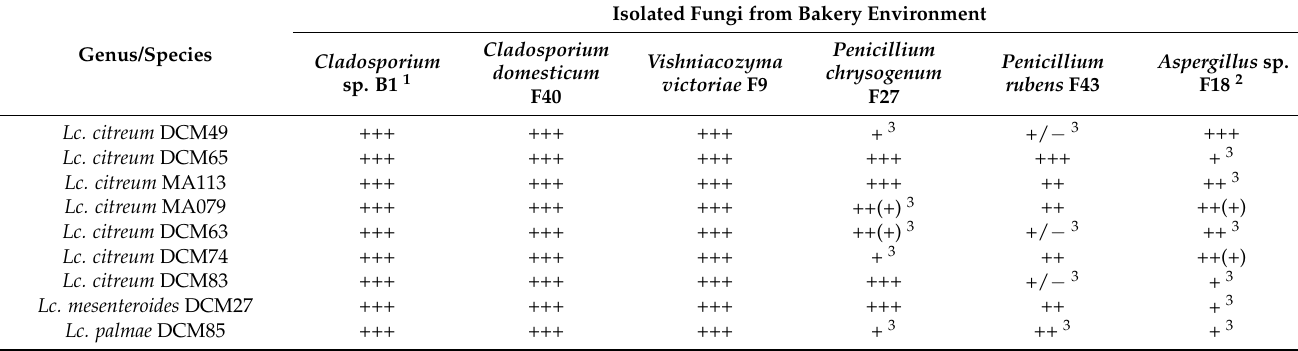
Table 4. Inhibition spectrum of nine Leuconostoc strains determined on WHF medium against six fungal contaminants of a bakery environment with Cladosporium sp., Penicillium sp., and Aspergillus sp. as representative moulds and Vishniacozyma sp. as yeast example. Cladosporium sp. B1 was isolated from soft rolls, whereas the other fungal contaminants were isolated from facility air. Zones of inhibition (halo measured from edge of colony to edge of zone of inhibition): +++ = complete inhibition of fungi; ++(+) = > 5 mm with minor fungi growth; ++ = 2.5–4.9 mm; + 0.1–2.4 mm; +/- = no halo but a brightening of the medium; and - = no inhibition. Experiments were performed in triplicates if the mould was fully inhibited in the first run.